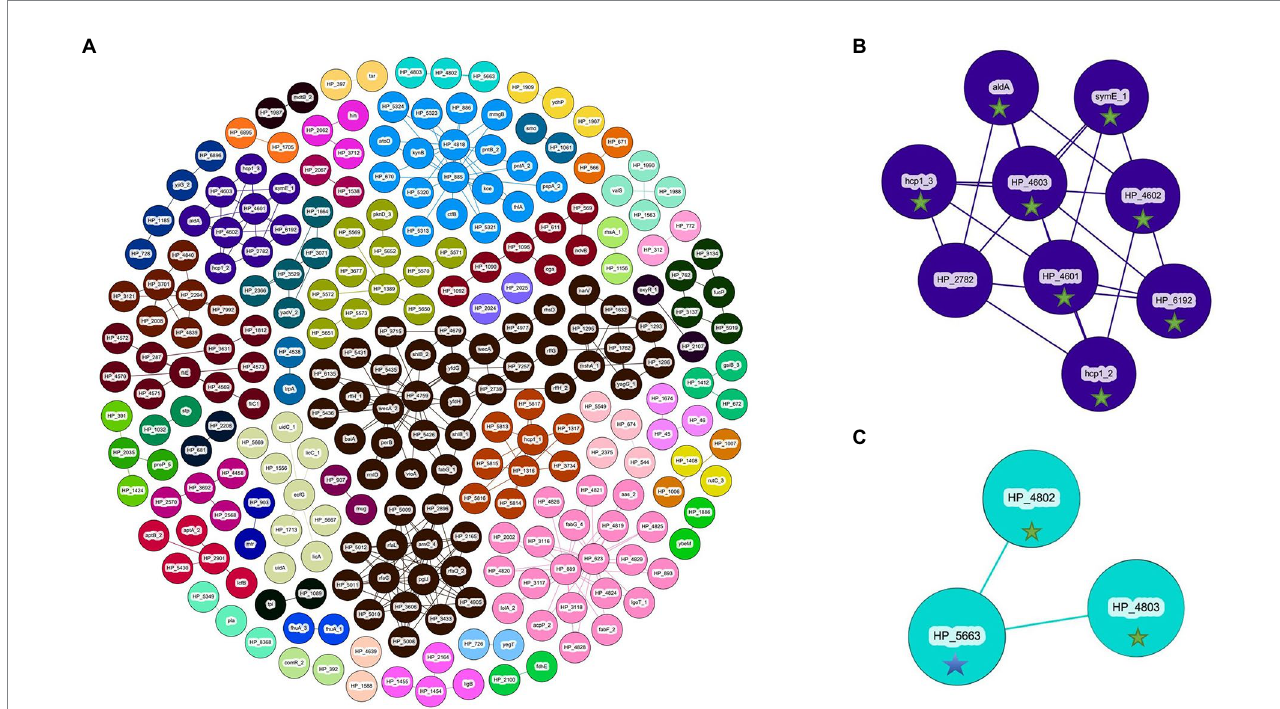
FIGURE 6 Coinfinder derived dissociation of gene pairs from Pantoea ananatis genomes ( N = 92) displaying various networks (A) . Gene-pair dissociation networks for components 23 (B) and 37 (C) are extracted due to their with foliar pathogenicity for A. fistulosum × A. cepa (green star) or association with foliar pathogenicity for A. porrum (blue star). Gephi was used to apply the Fruchtermann Reingold layout to the network (https://gephi.org/).For all node labels, “group_” was replaced by “HP_” (hypothetical protein) for legibility.